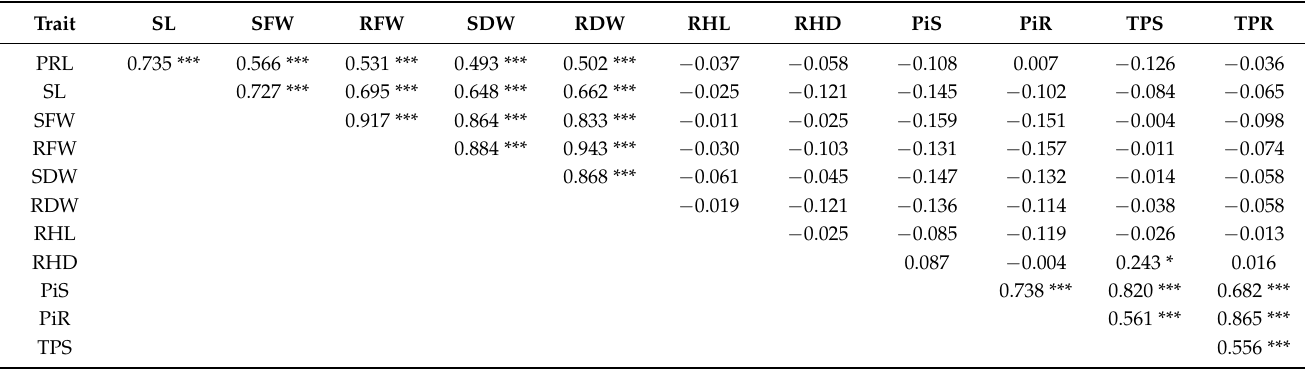
Table 2. Pearson’s correlation coefficients among agro-morphological and P-content-related traits in 100 finger millet F 2:3 RILs under LP conditions.